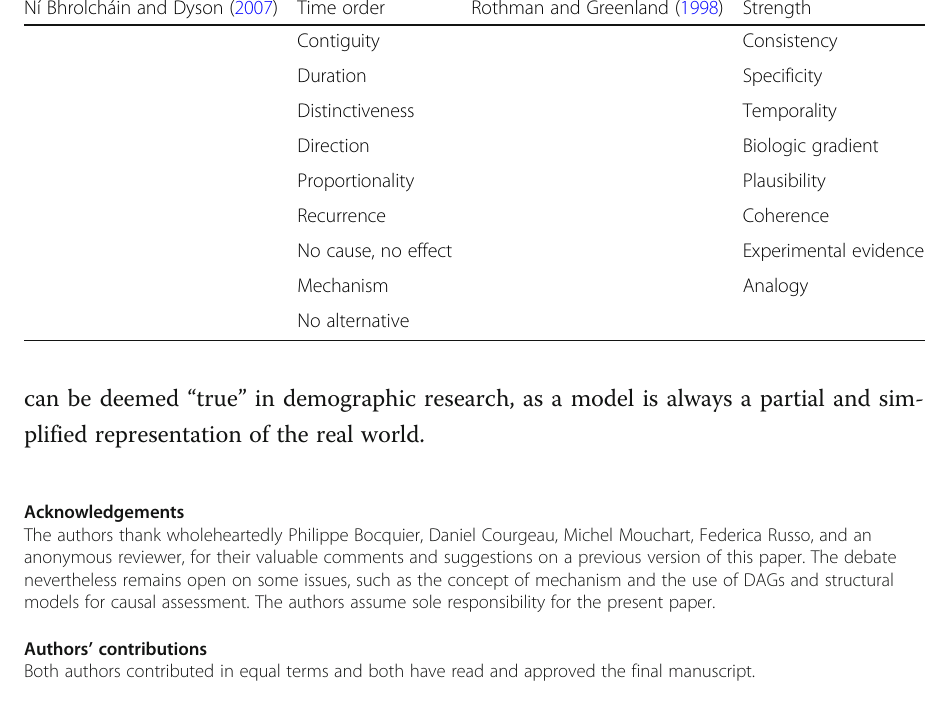
Table 1 Criteria of causal inference Ní Bhrolcháin and Dyson (2007) Time order Rothman and Greenland (1998)